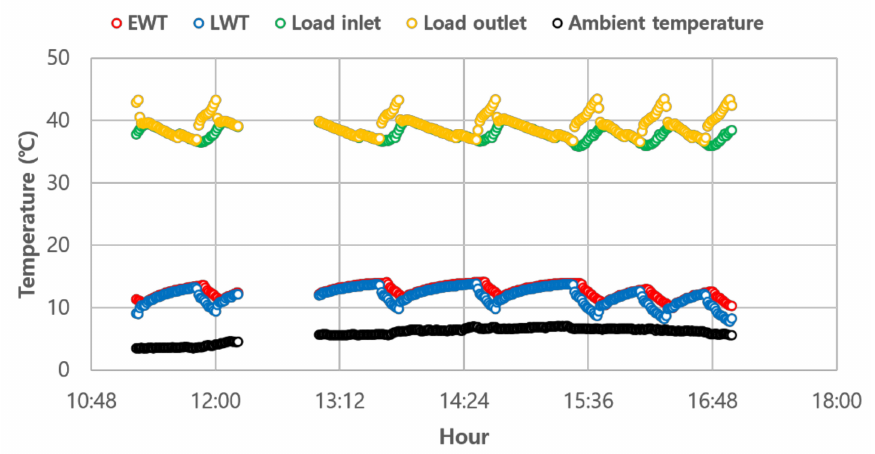
Figure 11. Heat source and load temperature.